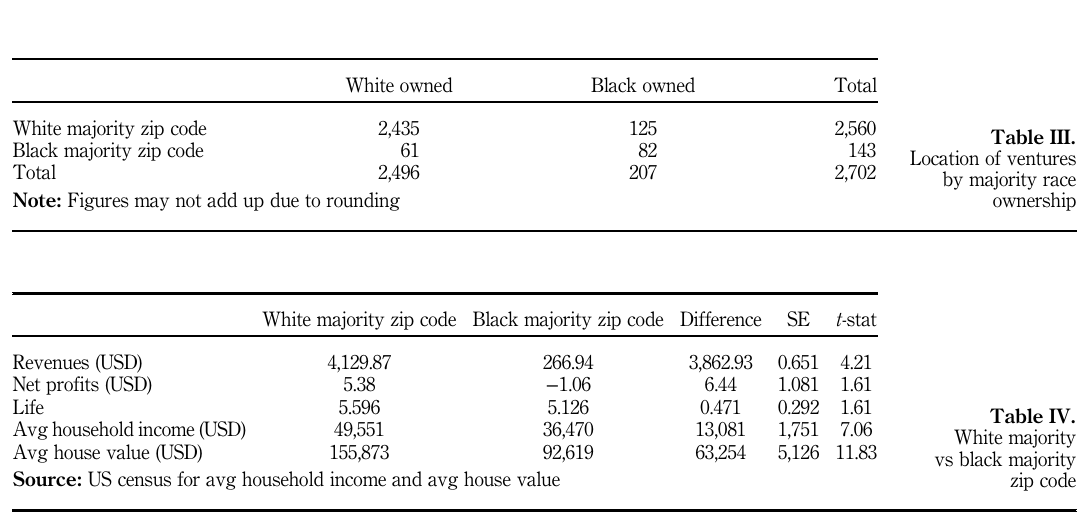
Table V tabulates the differences in some key variables between white- and black-owned ventures in white and black majority zip codes. In most cases, the white-owned ventures in white areas possess the most favorable attributes, and black ventures in black majority zip codes are the worst off. A similar pattern is observed in the outcome variables such as revenues and profits. However, survival seems to be comparable across race and location, except for black-owned businesses in black majority